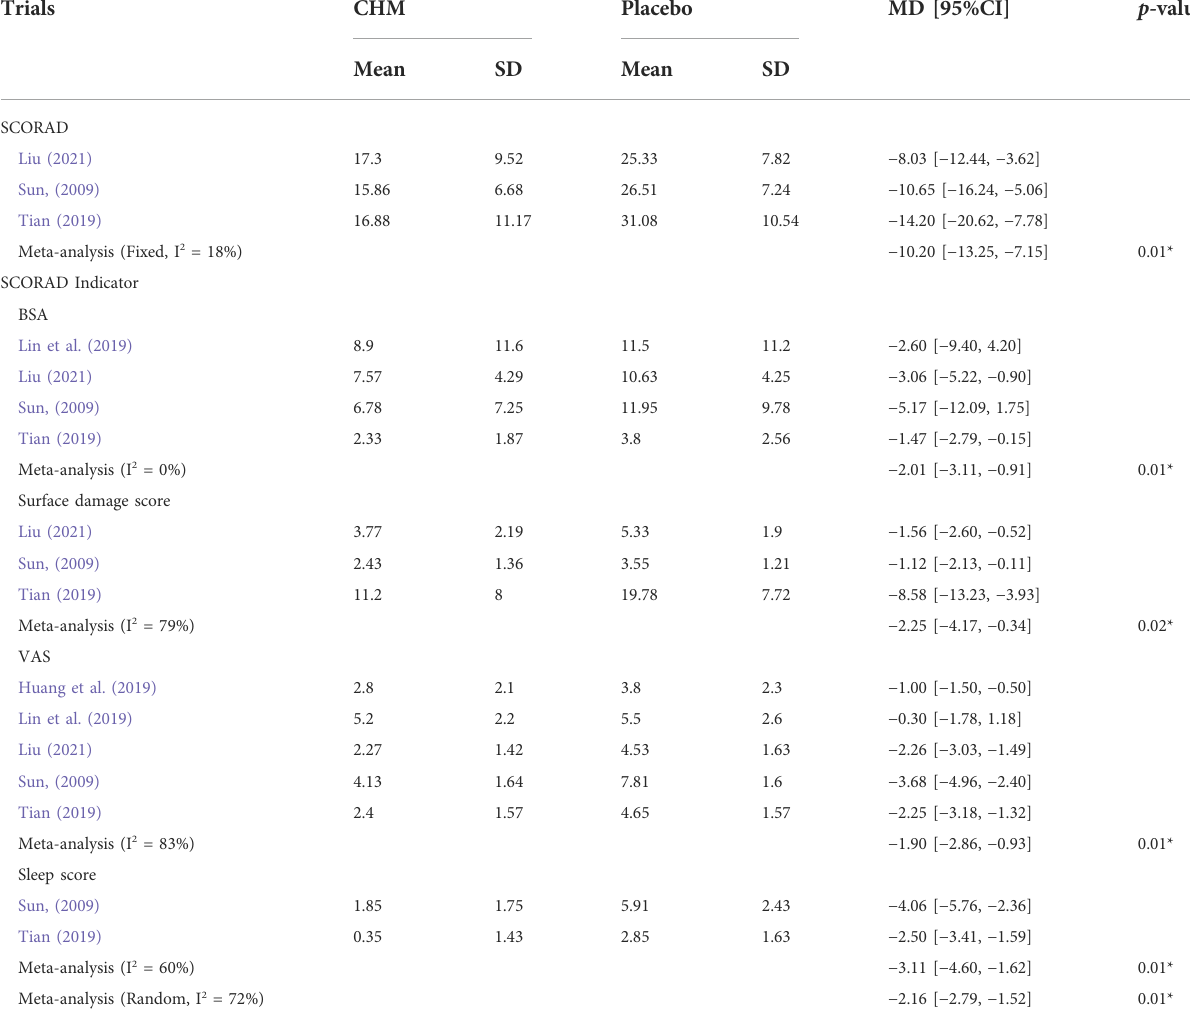
TABLE 3 The secondary outcome of ef fi cacy between the CHM and placebo groups.